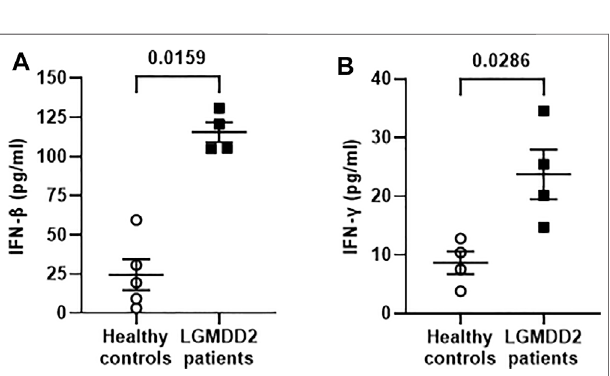
FIGURE 6 | Antiviral cytokines pro fi le in plasma samples of healthy controls and LGMDD2 patients. Levels (pg/ml) of antiviral cytokines IFN β (A) and IFN γ (B) were quanti fi ed in plasma of healthy controls and LGMDD2 patients showing a signi fi cant increase in both IFN (p-values = 0.0159 and 0.0286,